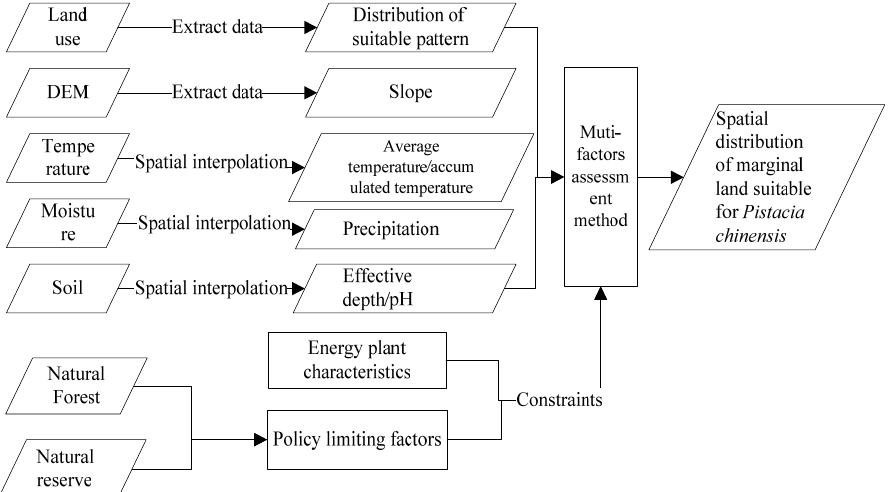
Figure 1. Workflow of spatial distribution and suitability evaluation for energy land